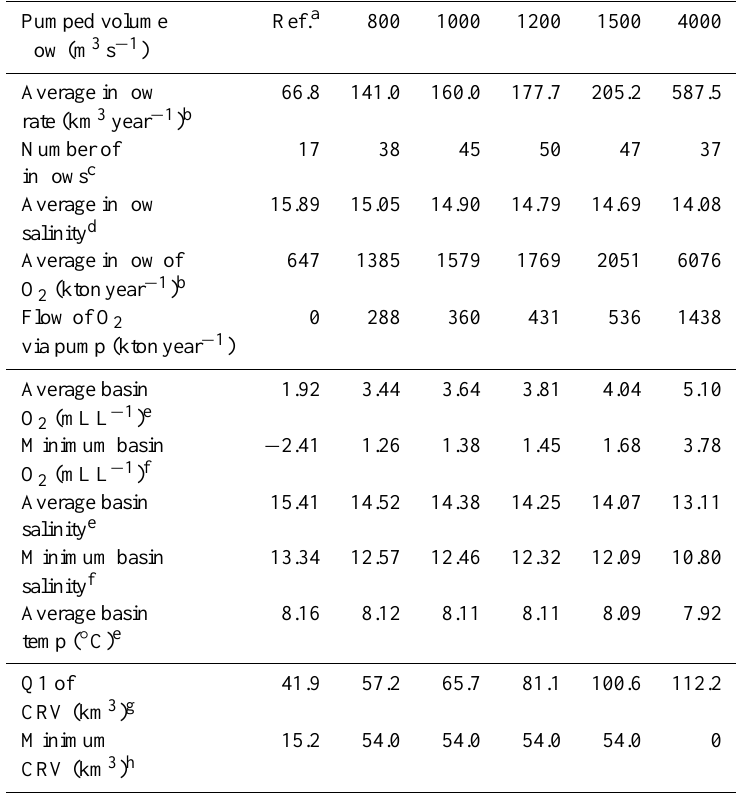
Table 2. Model results for 1990–2010 with the pump intake placed at 30m depth and for different pumping